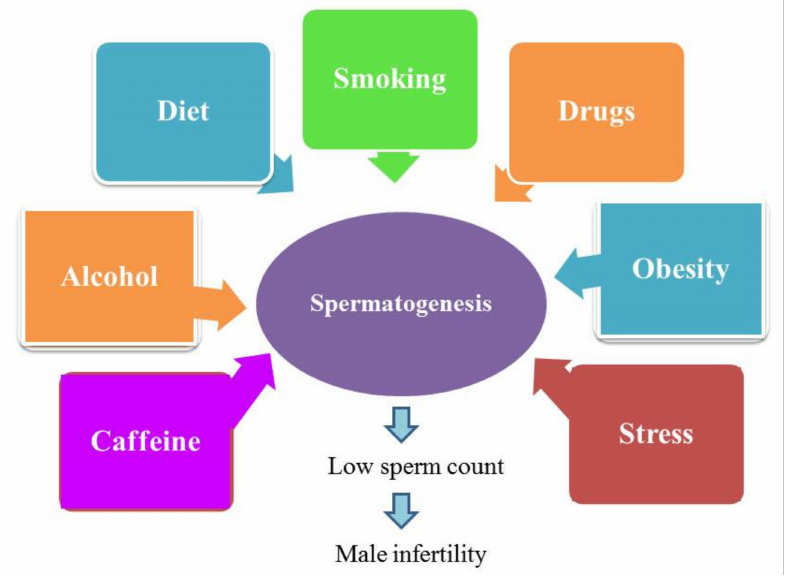
Figure 1. Lifestyle causes male